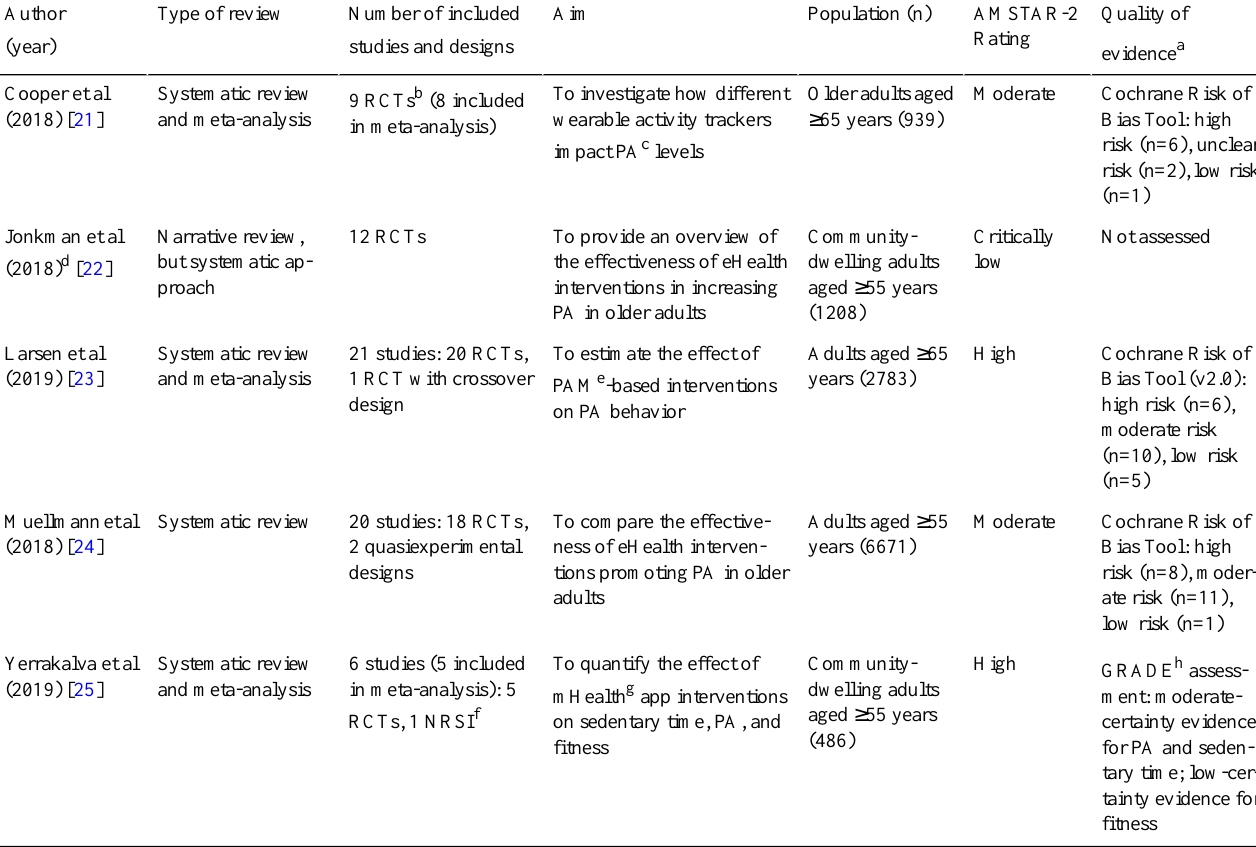
Table 1. Summary of review characteristics and quality